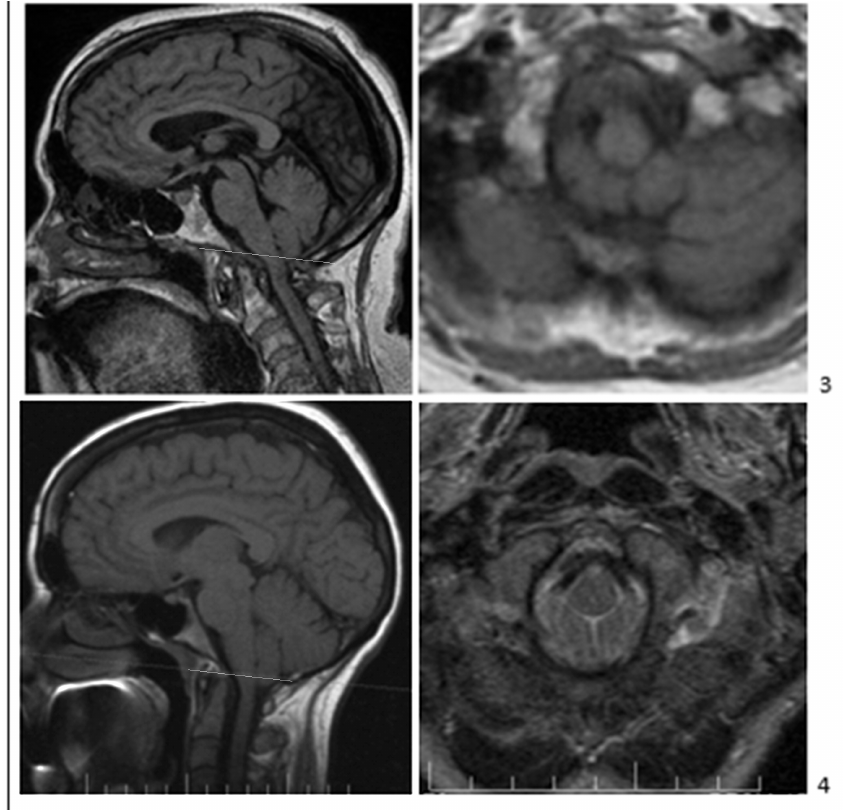
Figure 2. Types of CM0 without syringomyelia. The McRae line (white line) is shown on the T1- weighted sagittal images (left panels). Axial images at McRae’s line are shown (right panels) on T1-weighted ( 3 ) and T2-weighted ( 1 , 2 , 4 ) images. Adult symptomatic CM0-only patients with tonsillar herniation ≤ 2 mm (panels ( 1 – 3 )) and borderline CM1-only patients with tonsillar herniation 3 mm ( 4 ). All patients demonstrate short bones (CL and SO < 40 mm), crowdedness of the PCF, tight fora- men magnum, and CM1-like clinical manifestations: transient localized suboccipital cough-related headaches ( 1 ) or constant and transient suboccipital headaches ( 2 – 4 ), truncal ataxia, vertigo, dizzi- ness, and upper motor neuron signs. The sagittal images in ( 1 , 3 ) (left panels) also show spinal canal narrowing at the level of the odontoid.